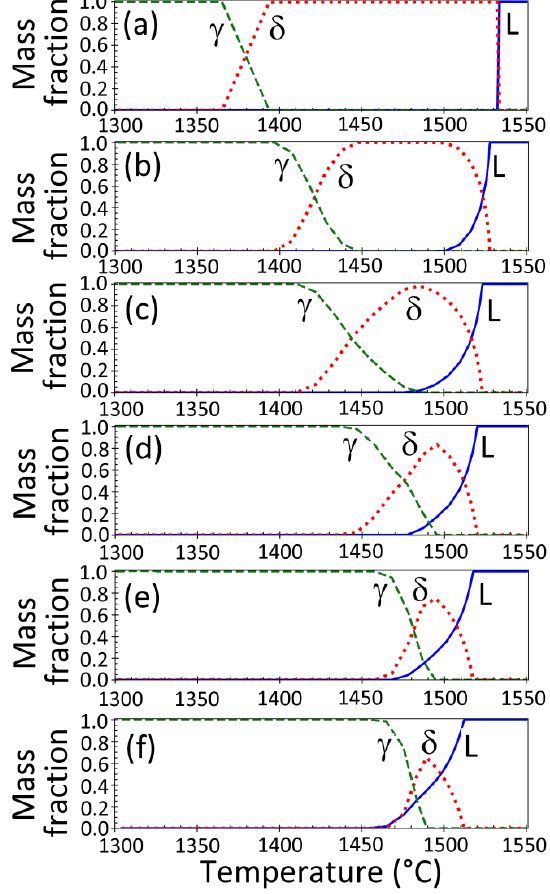
Figure 2. Phase fractions for six different examined steel grades: ( a ) Fe-0.003%C; ( b ) Fe-0.05%C; ( c ) Fe-0.10%C; ( d ) Fe-0.12%C; ( e ) Fe-0.16%C, and ( f ) Fe-0.23%C. Metals 2022 , 12 , x FOR PEER REVIEW